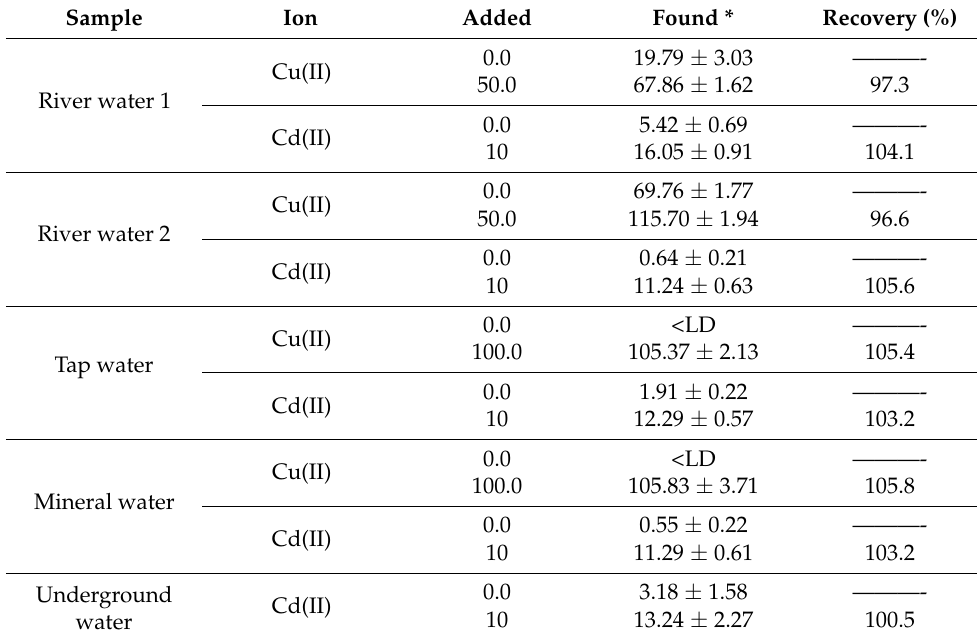
Table 10. Determination of Cu(II) and Cd(II) in water samples, with and without the addition of a standard metal solution.